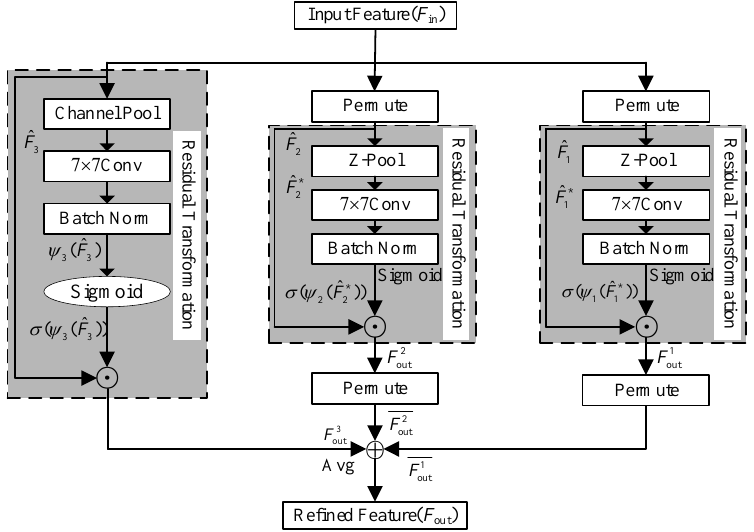
Figure 4. The architecture of the convolutional triplet attention module (CTAM) [21] .